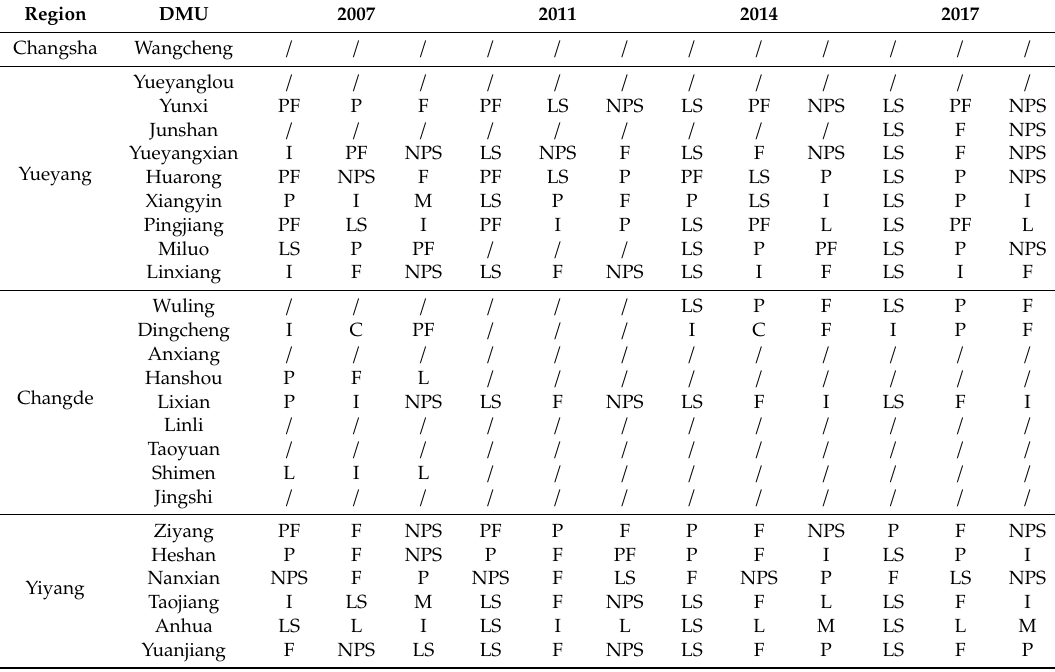
Table 6. Top three input–output factors a ff ecting the cultivated land use e ffi ciency. Region